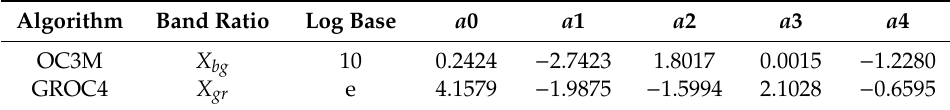
Table 4. Coe ffi cients of the OC3M and GROC4